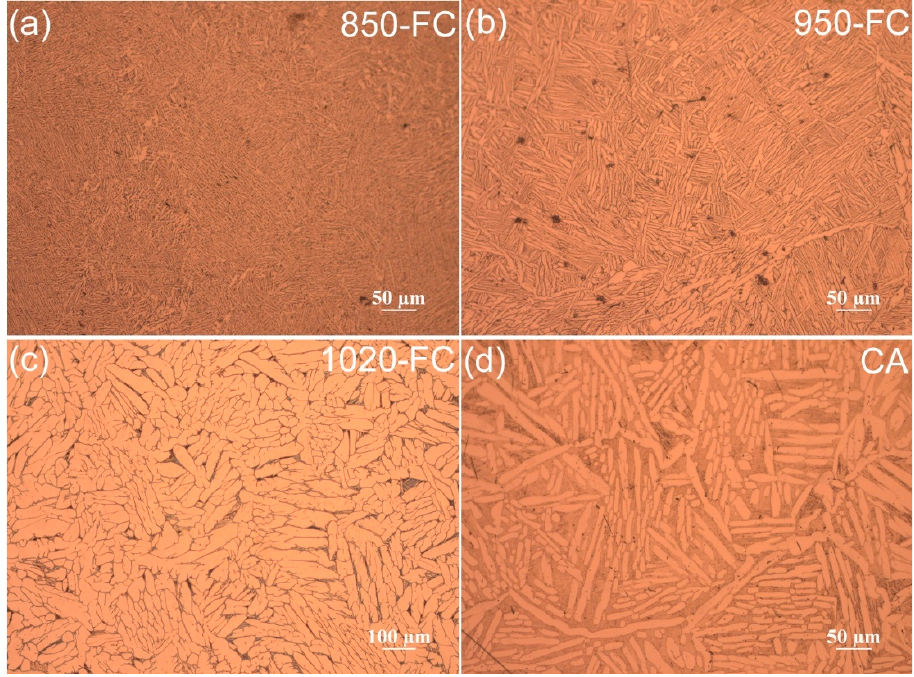
Figure 6. OM images showing the α + β structure of Ti64: ( a ) 850-FC, ( b ) 950-FC, ( c ) 1020-FC and ( d ) CA samples.